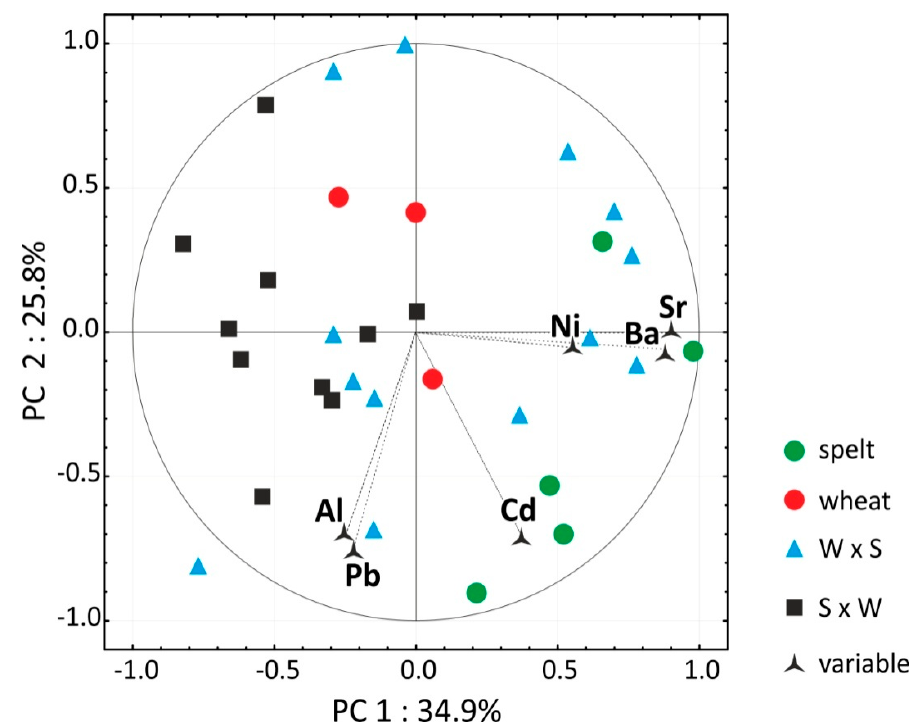
Figure 4. Biplot presenting PCA results for the contents of six undesirable microelements in the grain of the studied cereals. W × S—wheat × spelt; S × W—spelt × wheat hybrids.